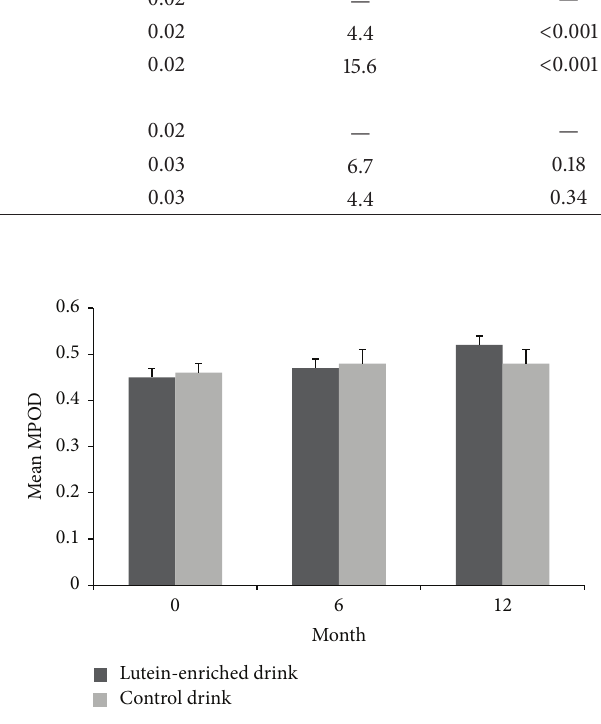
Figure 4: Mean ± SE macular pigment optical density (MPOD) in time for the lutein group (dark grey bars) and the placebo group (light grey bars). MPOD increased significantly in the lutein group as compared to the control group ( 𝑃 < 0.05